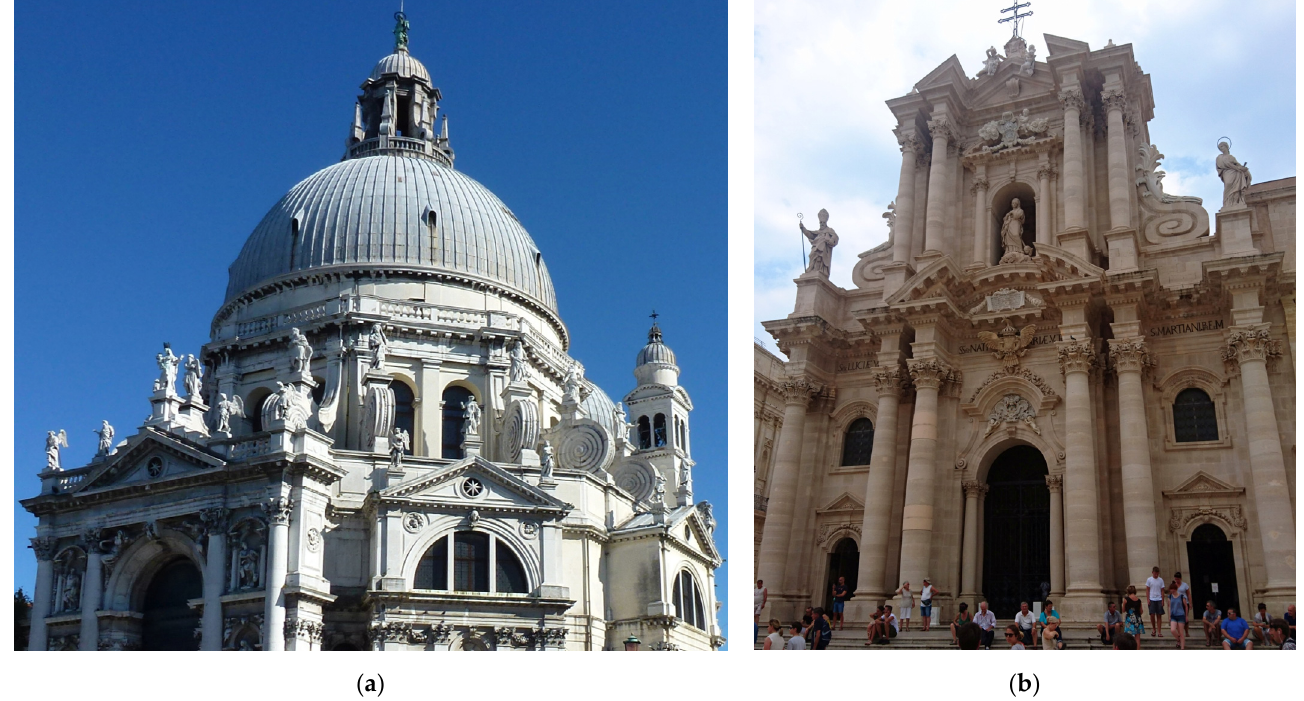
Figure 3. Monochromatic façades ( a ) made of pietra d’Istria —the façade of the church of S. Maria della Salute in Venice; ( b ) made of local limestone—the Cathedral of the Nativity of the Blessed Virgin Mary in Syracuse (1725–1753). Photo by author and from private collection.